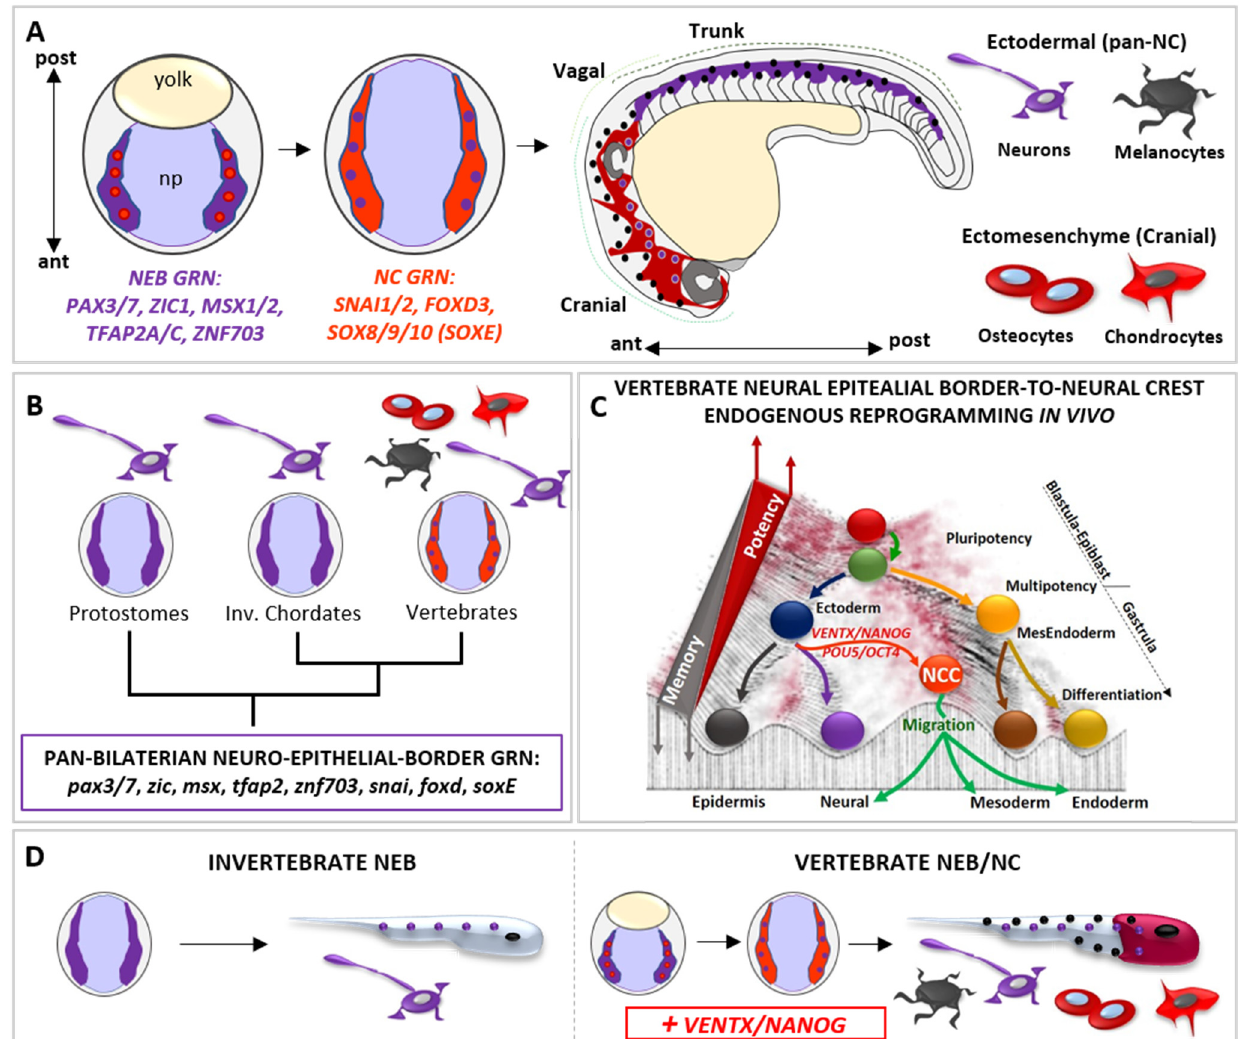
Figure 3. The vertebrate-specific neural crest cells (NCCs) are empowered with multipotency and ectomesenchyme potential by vsDPGs VENTX / NANOG and POU5 / OCT4 . ( A ) Schematic represen- tation of neural epithelial border cells (NEBs, in purple plus red dots, gastrula stage) specification to neural crest cells (NCCs, in light red plus purple dots, neurula stage) during vertebrate development. Vertebrate NEBs are specified during gastrulation and activate the NEB-specific gene regulatory network (GRN) centred on pax3 / 7 , zic1 , msx1 / 2 , tfap2 and znf703 orthologs (in purple). At the onset of neurulation, NEB-GRN activate the down-stream NCC-GRN, centred on snai1 / 2 , foxd3 , sox8 / 9 / 10 ( soxE ) orthologs (in light red). During morphogenesis, migratory NCCs (Cranial NCCs in dark red, Trunk NCCs in purple) migrate from the dorsal neural tube along the anterior-posterior (A/P) axis, loose multipotency and become competent to respond to pro-differentiating cues. Com- mitted NCCs colonize new embryonic loci and differentiate into ectomesenchyme cranial deriva- tives (e.g., chondrocytes and osteocytes of the skull, cells represented in dark red) and ectodermal derivatives (e.g., neurons and melanocytes along the A/P axis, cells are represented by purple and black dots). ( B ) Simplified cladogram representing bilaterian phyla where NEBs (in purple; proto- stomes and invertebrate chordates) are unipotent and neurogenic (purple; neuron) and where NEBs give rise to multipotent NCCs (in light red plus violet dots, vertebrates). Note that, based on